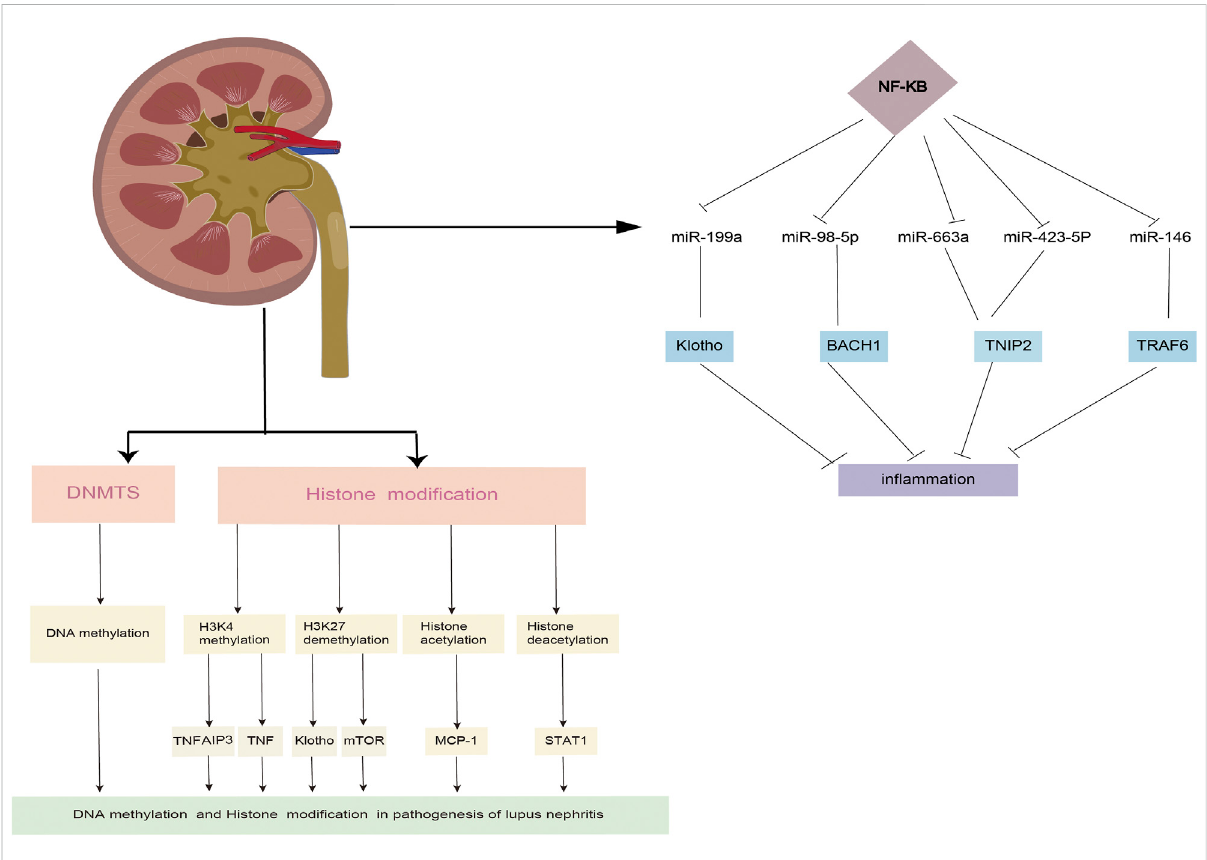
FIGURE 2 The roles of DNA methylation and histone modi fifi cation in the LN